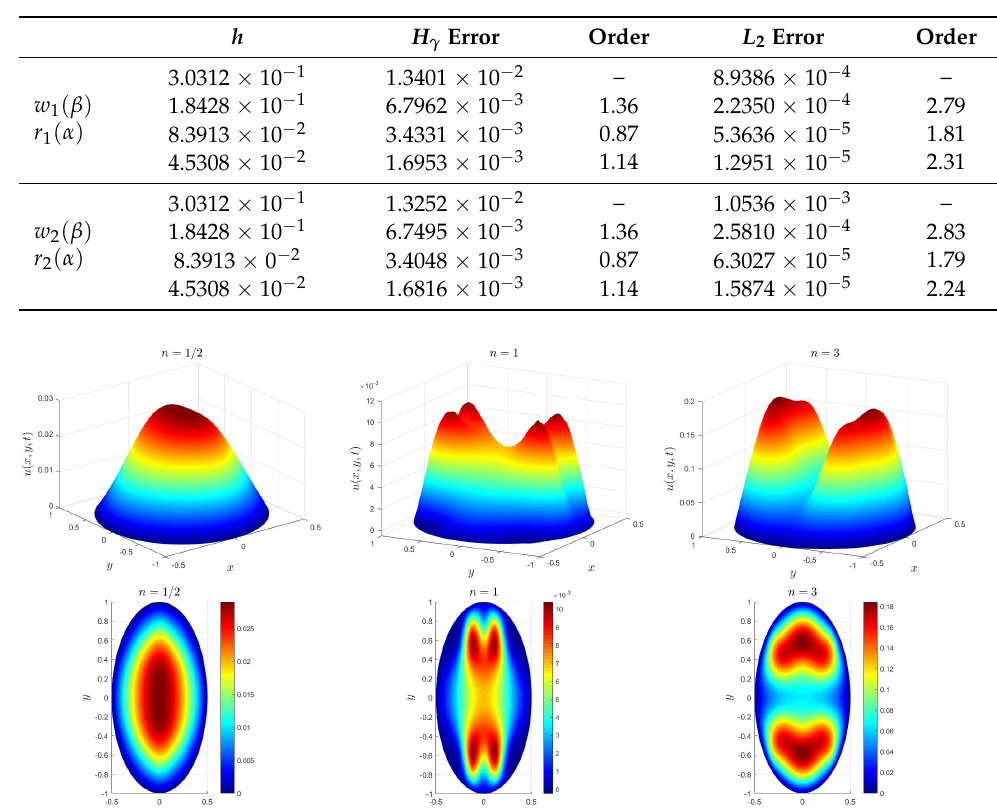
at t = 1 for the case ξ = 1, 1000